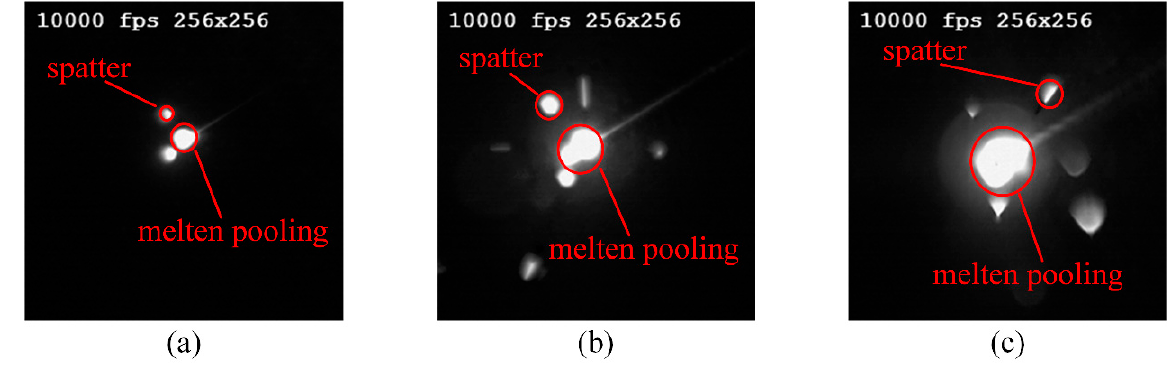
Figure 4. Typical images obtained by coaxial high-speed camera with different laser powers: ( a ) 25 W, ( b ) 125 W, and ( c ) 225 W